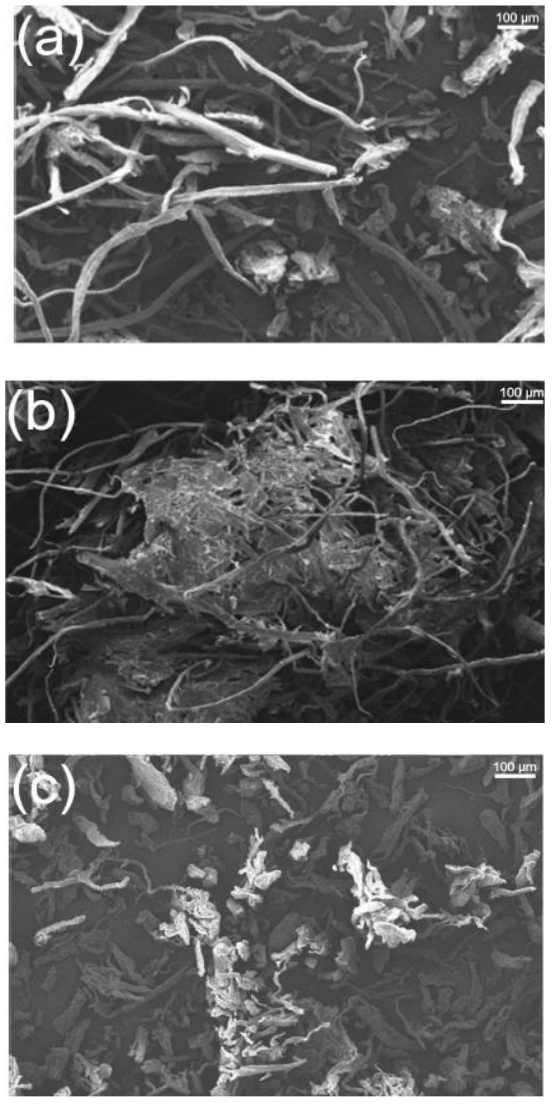
Figure 7. Morphology of isolated fibers from ( a ) corn husk, ( b ), stalk and ( c ) cob. Reprinted with permission from Ref [144], copyright 2022,